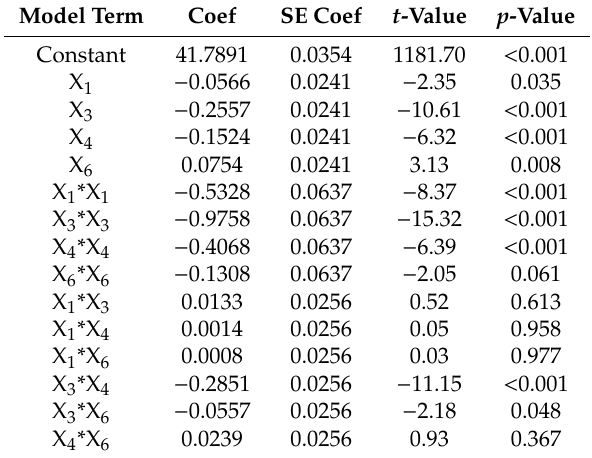
Table 8. Regression coe ffi cients significance: Coef, SE Coef, t -value, and p -value of the model terms (X 1 , X 2 , X 3 , X 4 ) and their interactions are noted. The t - and p -values were determined by using JMP 13 (SAS Institute, Wittington House, UK). Model Term Coef SE Coef t -Value p -Value Constant